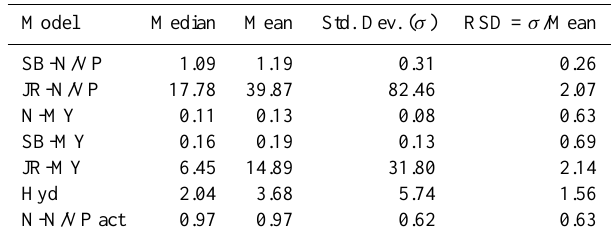
Table 3. Some statistics for the variation in factor difference in SOA mass with ( p 0 ) and ( γ i ) models compared to the base case – see Fig. 2.